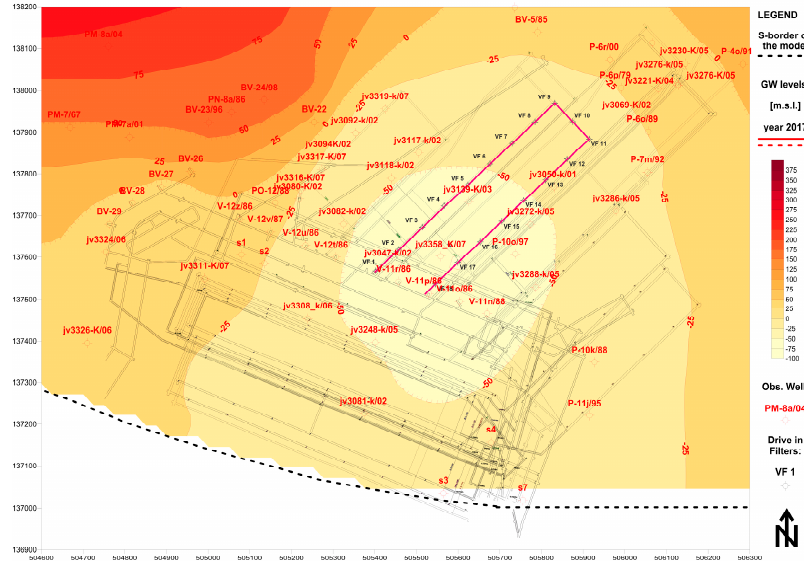
Figure 8. The groundwater depression level predicted to follow 360 days of work on the longwall face in the year 2017 using FeFlow 6.1. All underground vertical wells are depicted. Legend is in m.s.l.